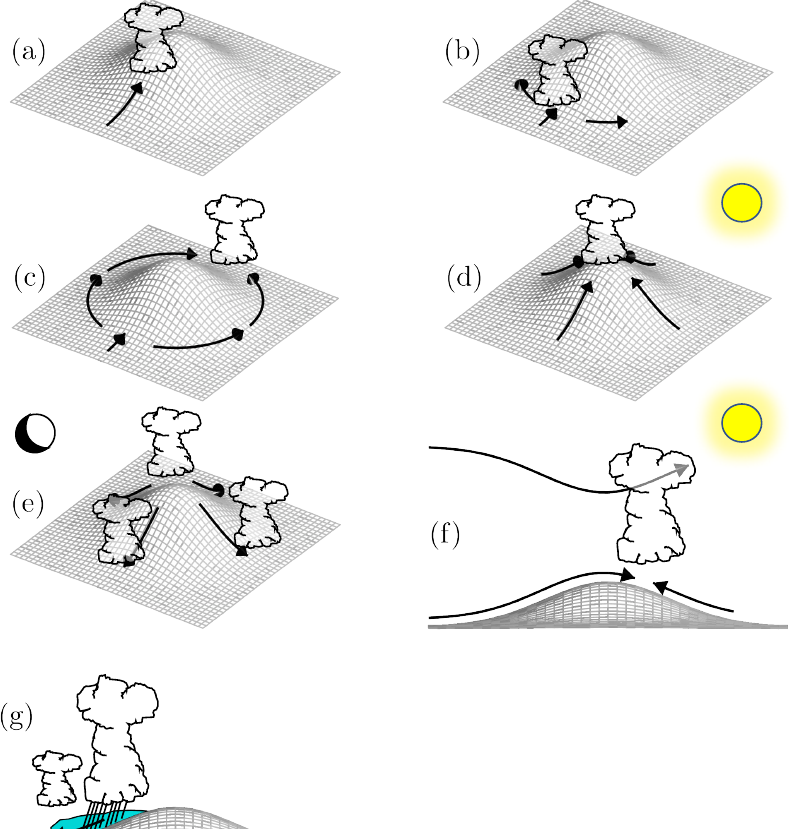
Figure 6. Schematic of basic mechanisms of convective initiation over mountains: ( a ) forced ascent, ( b ) upstream blocking, ( c ) lee-side convergence, ( d ) thermally forced anabatic flow and convection over the crest, ( e ) nocturnal katabatic flow and convection near the mountain base, ( f ) lee-side thermally driven upslope flow and gravity-wave ascent aloft, ( g ) quasi-stationary cold pool beneath precipitating